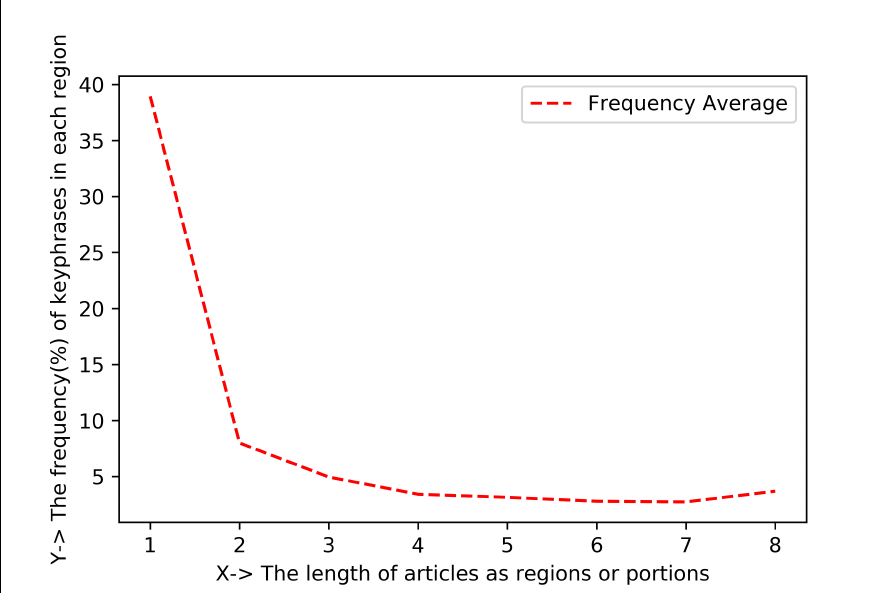
Figure 9. The analysis of Avg centroid value of all datasets using the same consideration for KCFA technique.